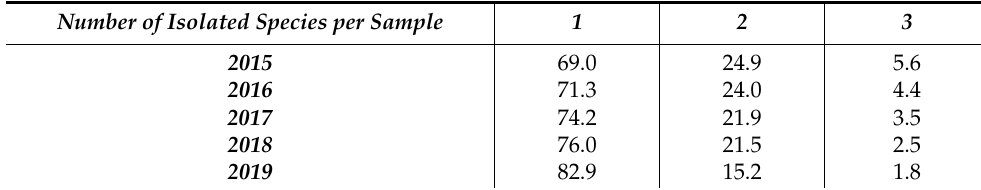
Table 3. The rates of the number of isolates per positive sample.